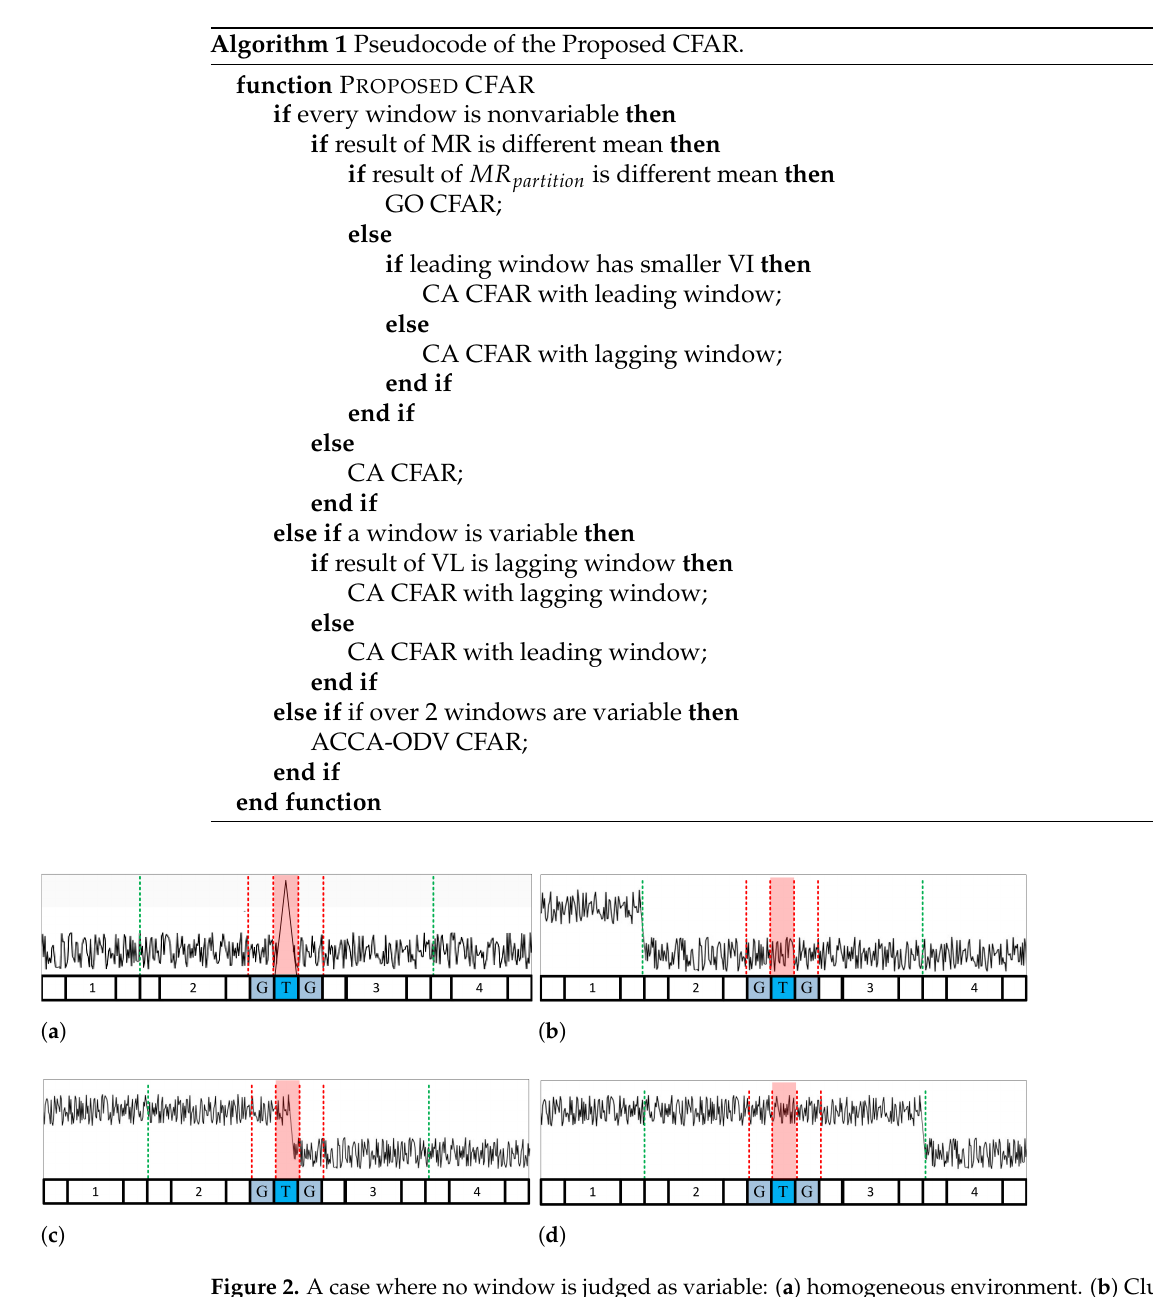
Figure 2. A case where no window is judged as variable: ( a ) homogeneous environment. ( b ) Clutter edge is located in window 1. ( c ) Clutter edge is adjacent to the test cell. ( d ) Cutter edge is located in window